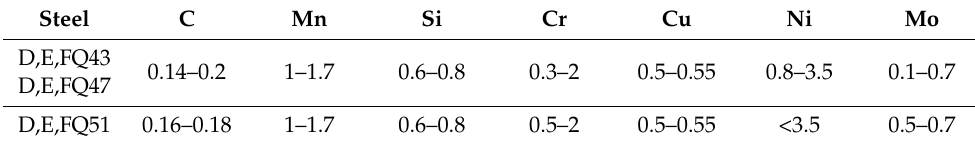
Table 3. Chemical composition of steels according to Rules of Materials and Welding of ABS,